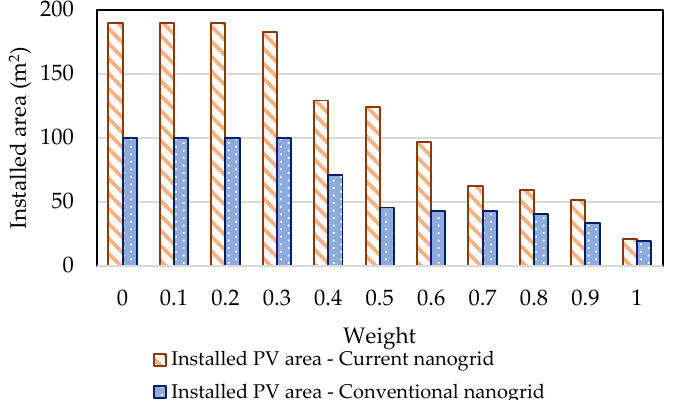
Figure 5. Installed PV area in optimized configurations of the current nanogrid and the conventional